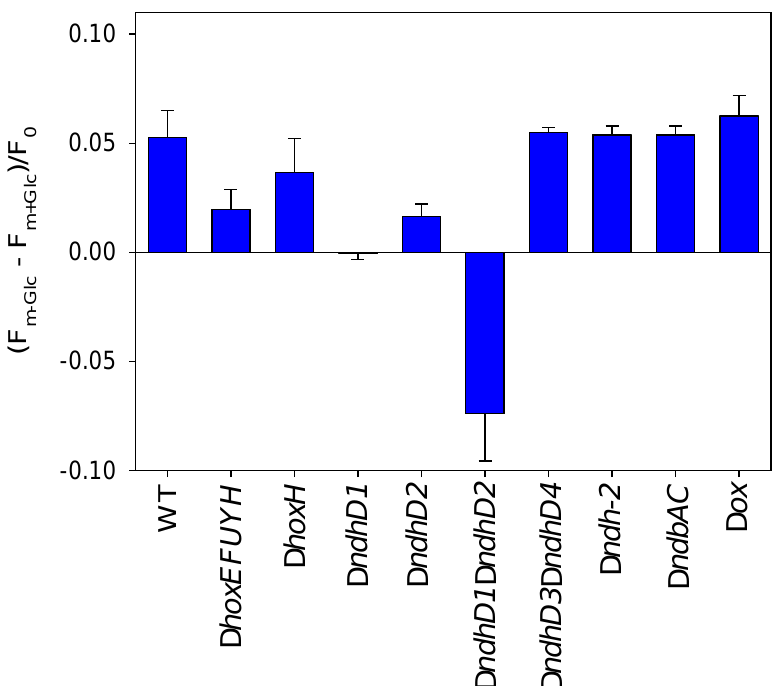
Figure 6. State change after glucose addition as measured by the PAM-fluorimeter of the different deletion strains. The cells were exposed to 120 µE/m 2 /s at the same density as in Figure 4 for about 3 min and the Fm measured (F m − Glc ). After glucose addition the cells were continuously exposed to the same light and after 3 min another Fm was measured (F m + Glc ). The difference between both F m should mirror the shift of antenna away from PSII because of the presence of glucose. At least three different cultures of the same strain were measured. The standard deviation is shown.